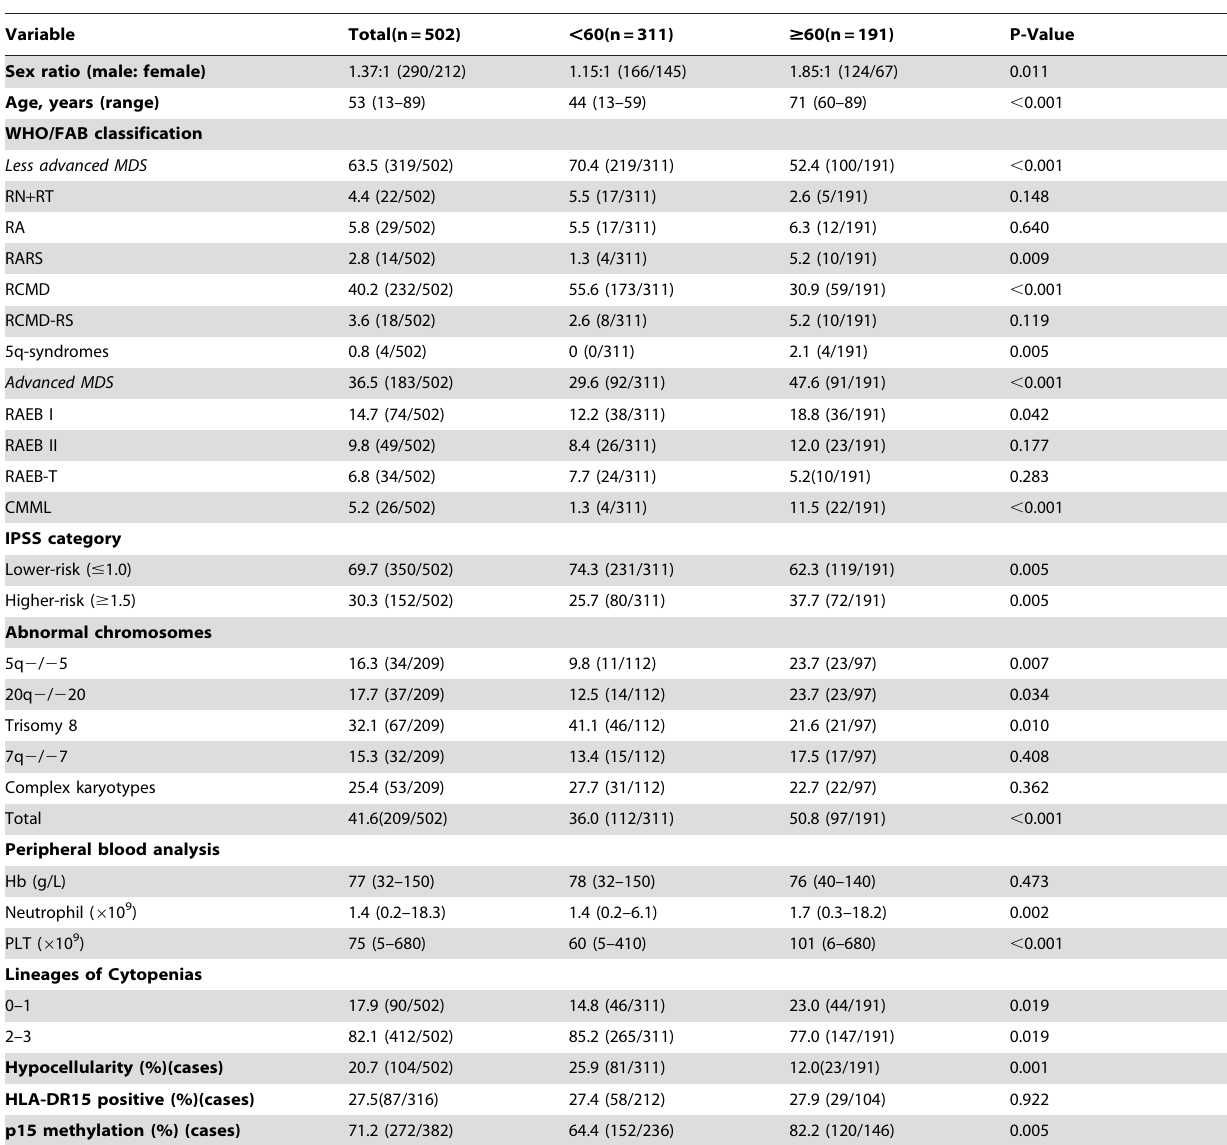
Table 1. Clinical characteristics of both younger and older MDS